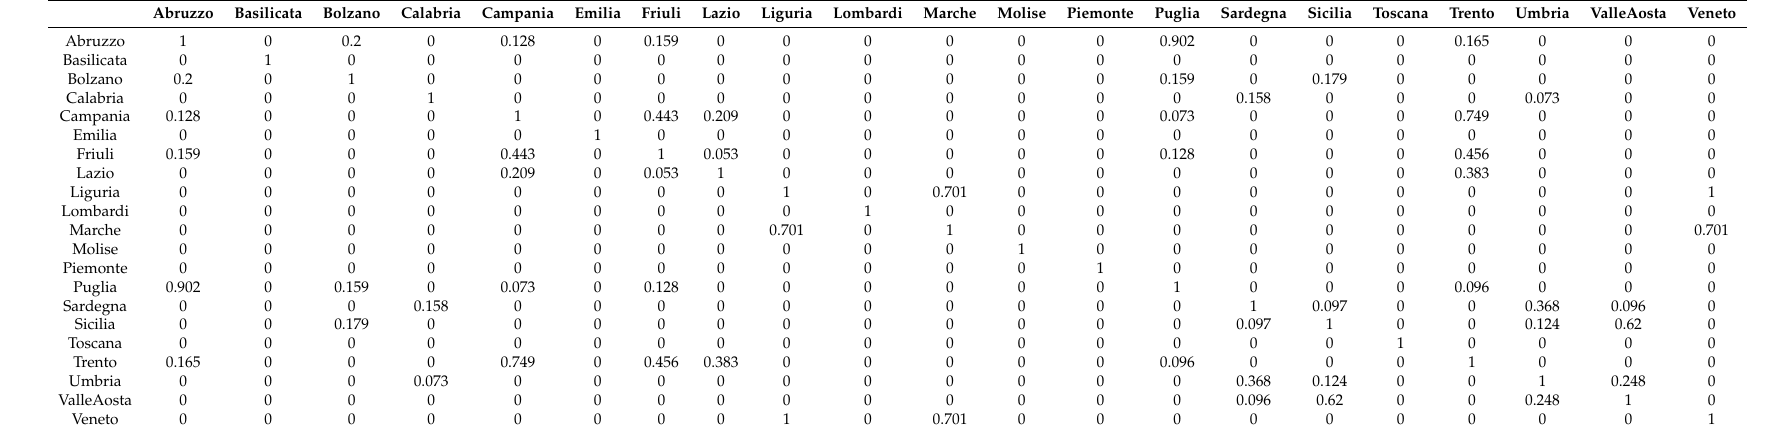
Table A48. Similarity values of Deceased network in the fifth